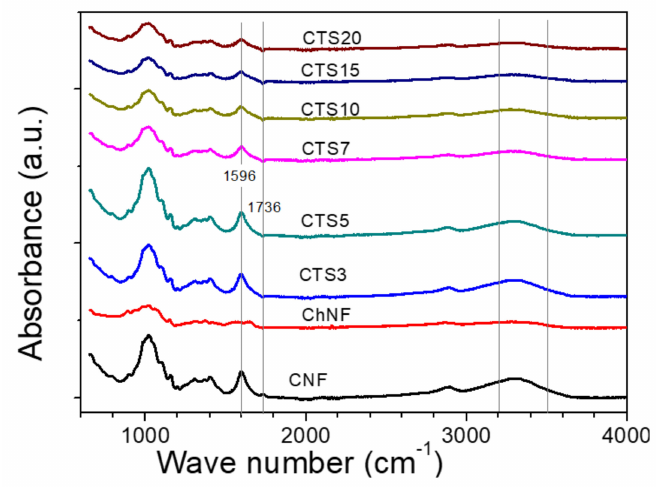
Figure 6. FTIR of CNF, ChNF and ChNF–CNF